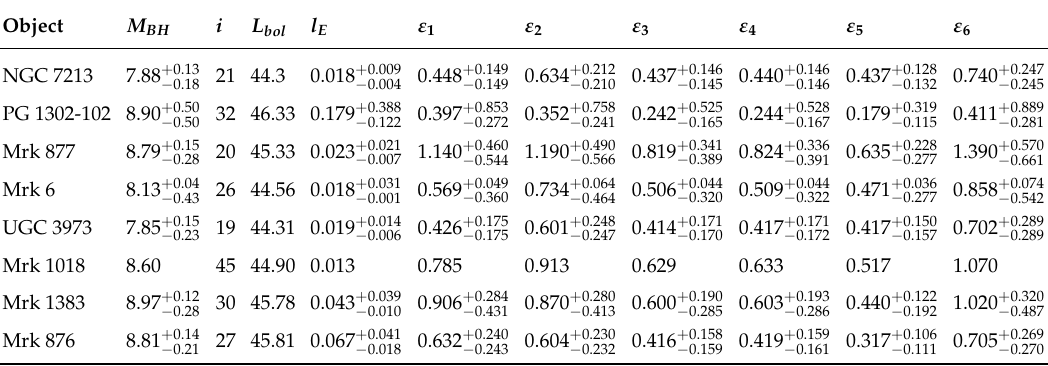
Table 1. The results of estimations of radiative efficiency for six popular models (see Section 3). Mass